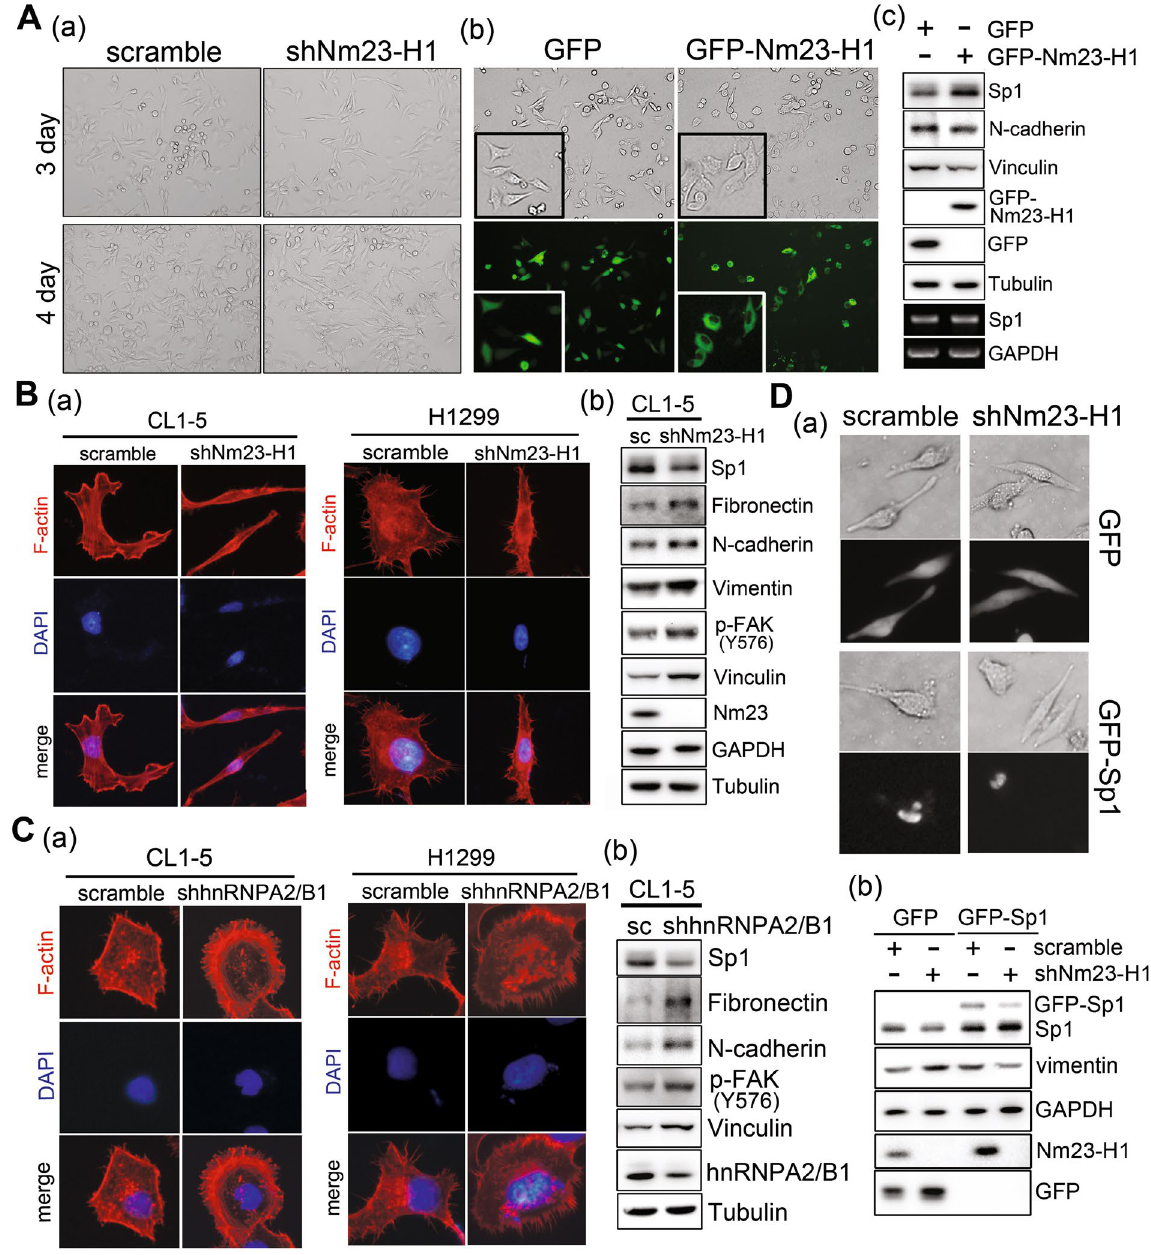
Figure 5. The role of Nm23-H1-mediated Sp1 expression in the epithelial and mesenchymal transition of lung cancer cells. ( A ) Morphology of CL1-5 cells with Nm23-H1 knockdown (a) or overexpression (b) was observed with a microscope (20x), and the samples harvested from GFP-Nm23-H1-over expressed cells were analyzed by Western blotting with antibodies against the indicated proteins (c). ( B , C ) The distribution of F-actin in the knockdown Nm23-H1 ( B ) or hnRNPA2/B1 ( C ) in CL1-5 and H1299 cell lines was studied by immunostaining with anti-F-actin antibodies (a). The EMT-related proteins were studied by Western blotting with antibodies against the indicated proteins (b). ( D ) Cell morphology was observed in Nm23-H1 knockdown cells with GFP or GFP-Sp1 overexpression (a), and various EMT-related proteins were analyzed by Western blotting with antibodies against the indicated proteins